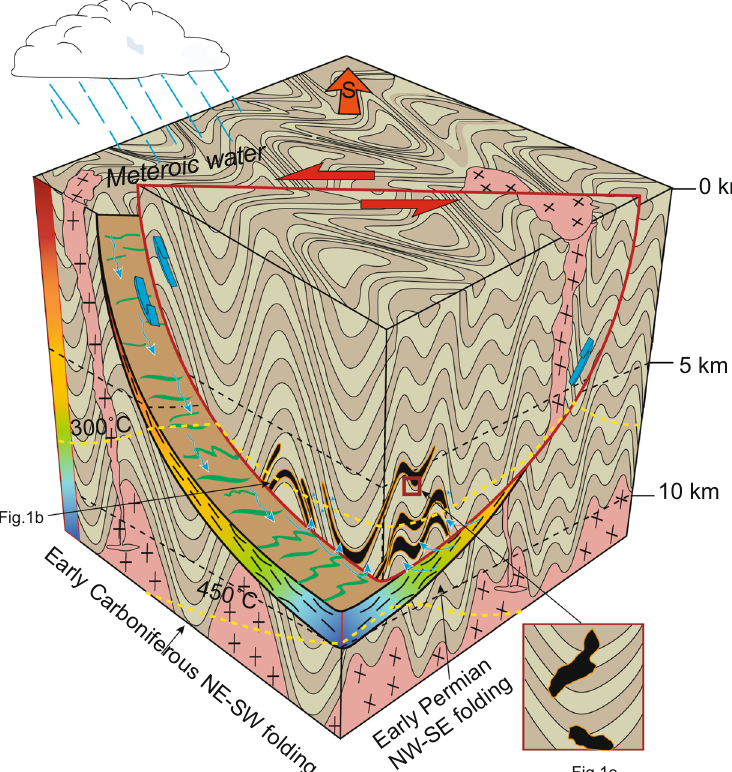
Figure 5. A conceptual model of the Mengku deposit. The model illustrates the shear movement and thrust motion circulating the meteoric water. Skarn iron ore layers follow with fold strata as in the Fig. 1b. The deformation styles and ages of the two stages of deformation of strata are from 19,26 . The inset corresponding to the Fig. 1e represents the skarn that cross-cuts the fold. The green lines on the shear zone indicate the shear direction. The pink rock is granitic basement. The color bar on the left is the relative water content the shear zone on a temperature color scale. The temperature of the shear zone increases and the water content decreases with the depth. The isotherm refers to Leloup et al . 36